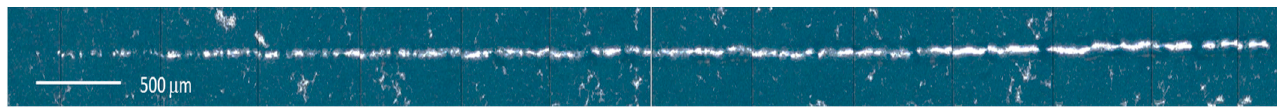
Figure 2. Scratch track of WC-Cr 3 C 2 -Ni coatings.